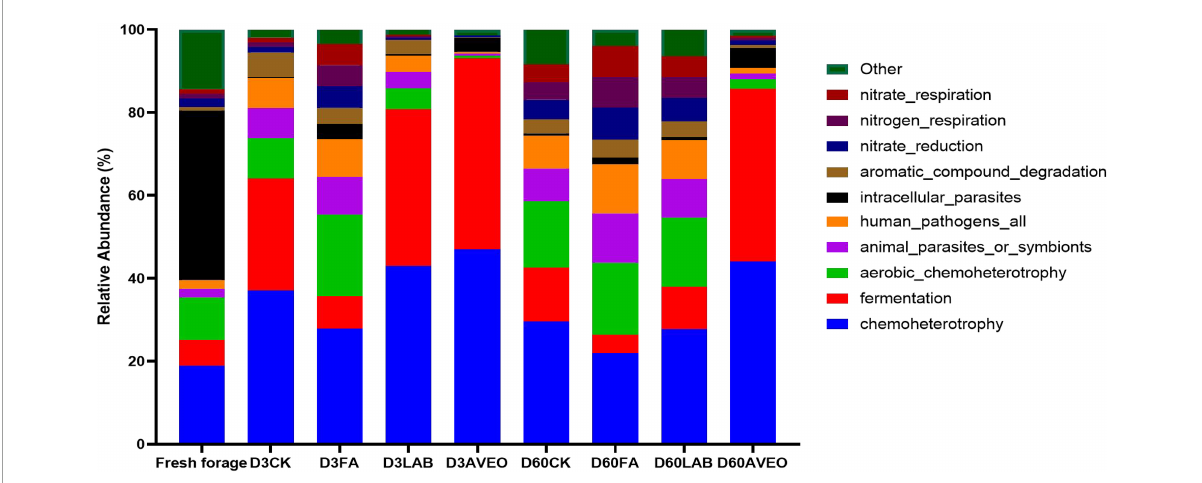
FIGURE2 Functional prediction for the bacterial community in fresh paper mulberry and the control without additives (CK) or with formic acid (FA); Lactiplantibacillus plantarum combined with Lactiplantibacillus buchneri (LAB); Amomum villosum essential oil (AVEO); D3, 3 days of ensiling; D60, 60 days of